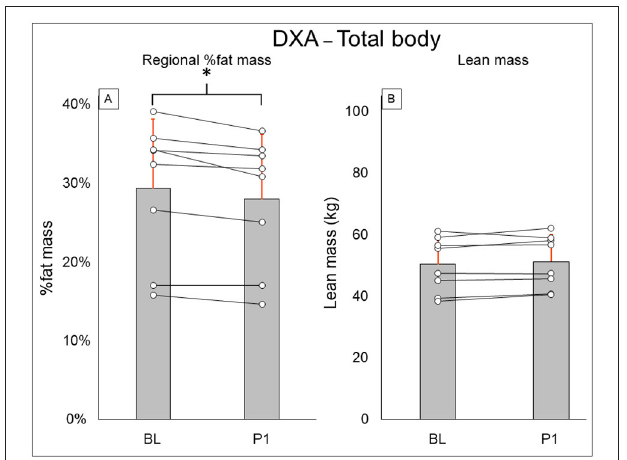
FIGURE 4 | Trunk DXA results for regional % fat mass (A) and lean mass (B) . Gray bars represent group averages (red lines showing SD), with dots connected by lines representing individual participants and their changes from baseline to post-intervention measurements. DXA, dual-energy x-ray absorptiometry; BL, baseline; PI, post-intervention. *Significant to P < 0.05.